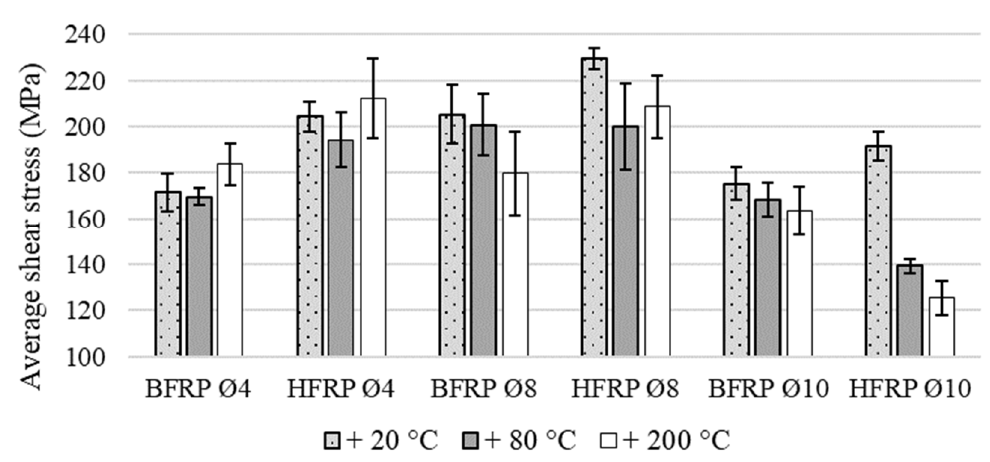
Figure 5. Comparison of the average shear strength for BFRP (basalt fiber-reinforced polymer) with HFRP (hybrid fiber rein-forced polymer) with average shear strength standard deviation (SD).